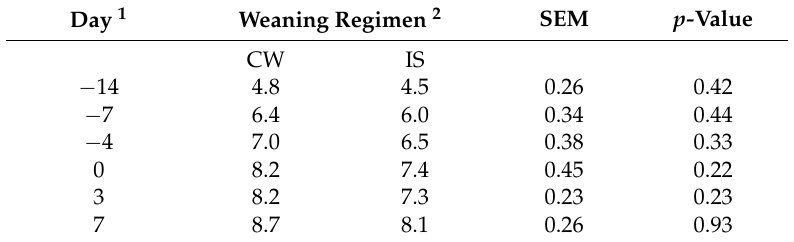
Table 1. Mean piglet body weight (kg) 14 days before weaning to 7 d after weaning for two different weaning regimens.